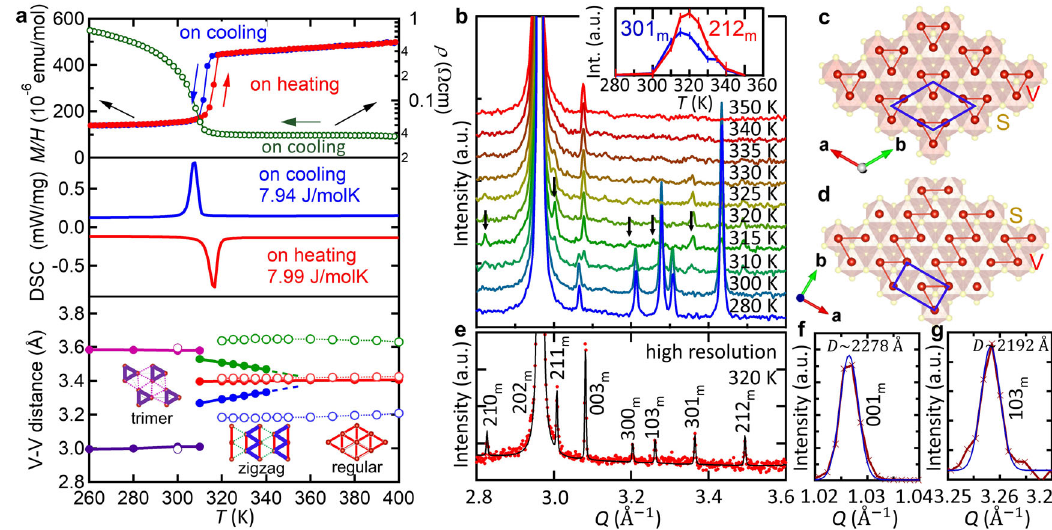
Fig. 1 Temperature dependences of the physical properties of LiVS 2 with structure deformations. a Temperature dependences of the magnetic susceptibility and resistivity (top), DSC data (middle), and adjacent V – V distances (bottom). Open circles are derived by analyzing the reduced PDF data in the range of 2 ≤ r (Å) ≤ 10, while the closed circles are from the Rietveld analysis of the powder diffraction data. Insets schematically depict the averaged structure obtained from Rietveld analysis in each temperature range. b Temperature dependences of powder X-ray diffraction data. Arrows indicate peaks that appear just above the trimer transition temperature of 314 K, which weaken upon further heating and disappear around 350 K. Detailed results of Rietveld analysis for each temperature regions were summarized in Supplementary Note 1. Inset shows the temperature dependences on superstructure peak intensity. c Schematic of vanadium trimers realized below 314 K. d Schematic of vanadium zigzag chain appearing with a fi nite correlation length in the high-temperature paramagnetic phase. e High resolution X-ray diffraction patterns at 320 K with indices of monoclinic phase. f , g Enlarged views of a fundamental 001 peak ( f ) and a superstructure 103 peak ( g ) with the correlation length estimated using the Scherrer equation. Instrumental resolution is not taken into account. These data are obtained from the high-resolution